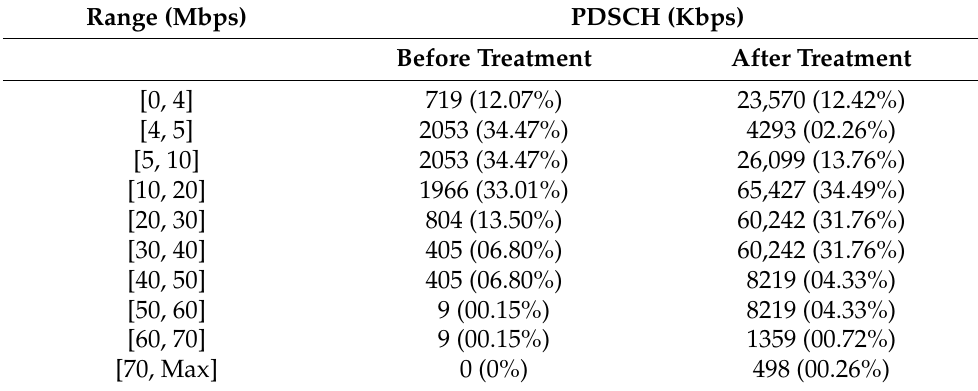
Table 4. PDSCH physical values before and after treatment.